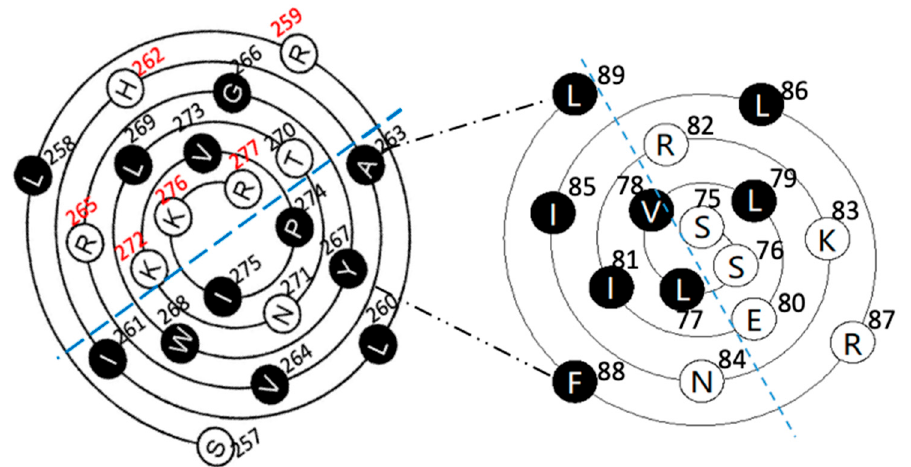
Figure 3. The schematic of the relative position and interaction between the PSTD and the PBR using the helical wenxiang diagrams of the PSTD and the PBR, respectively. All hydrophobic residues are labelled in black, and the closest distances between the residues of the two helices are in dash-dotted lines.